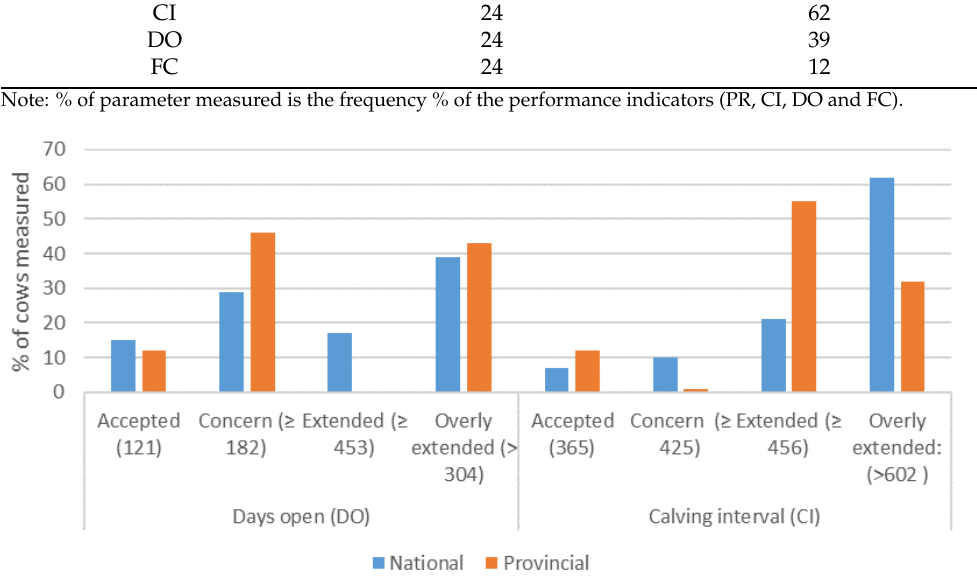
Reproduction Parameters Parameter Herd